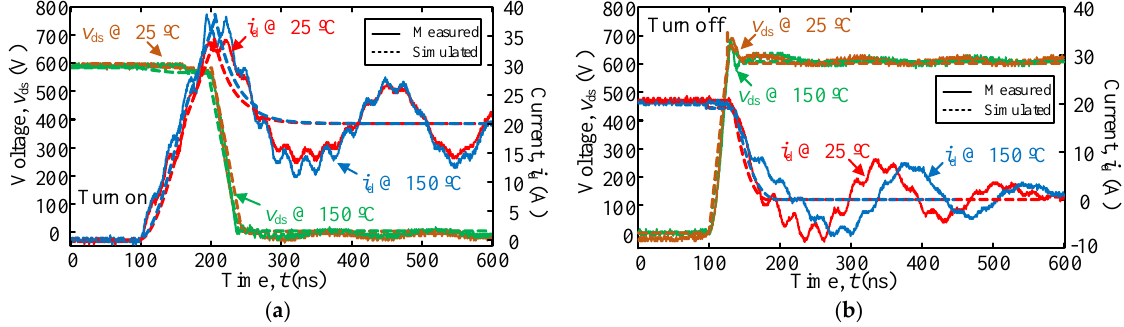
Figure 11. Switching waveforms of SiC MOSFETs ( a ) turn-on; ( b ) turn-off; @ 𝑅 G = 5 Ω .